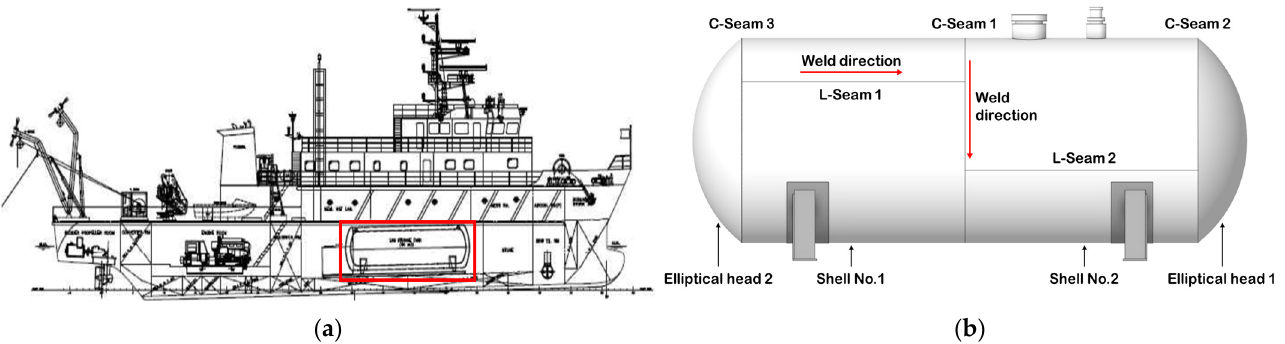
Figure 1. The welding configuration of the LNG fuel tanks in LNG-fueled ships: ( a ) concept of general arrangement design; ( b ) schematic diagram of the LNG fuel storage tanks.